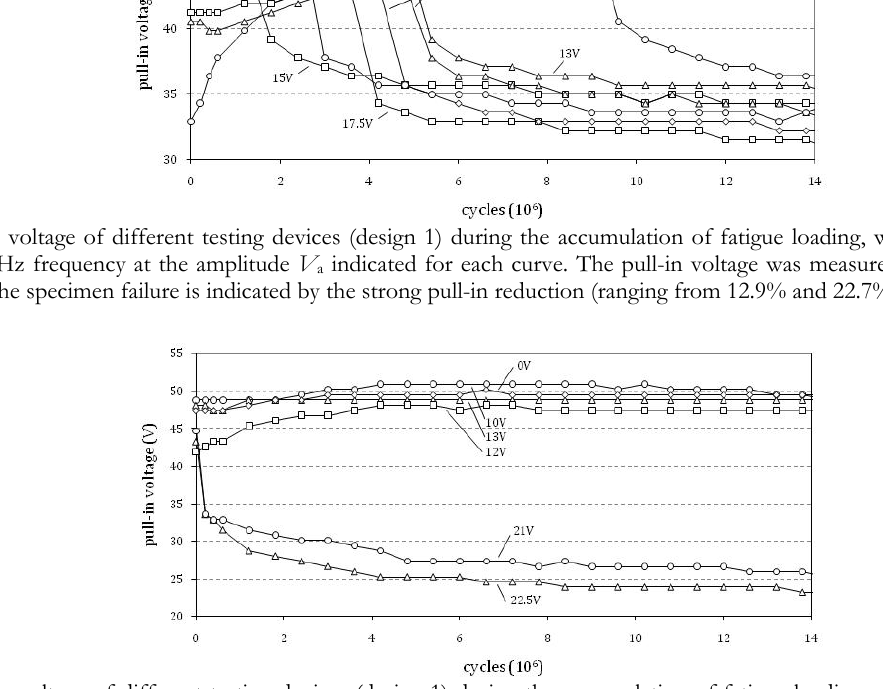
Figure 10: Pull-in voltage of different testing devices (design 1) during the accumulation of fatigue loading, with alternate load being provided at 20kHz frequency at the amplitude V a indicated for each curve. The pull-in voltage was measured and stored at specific time intervals. Specimens that failed immediately ( V a = 21V and V a = 22.5V) or that did not fail ( V a = 10V, V a = 12V and V a = 13V) are reported. The curve labeled with V a = 0V represents the pull-in variation during the application of a series of consecutive static actuations without alternate fatigue